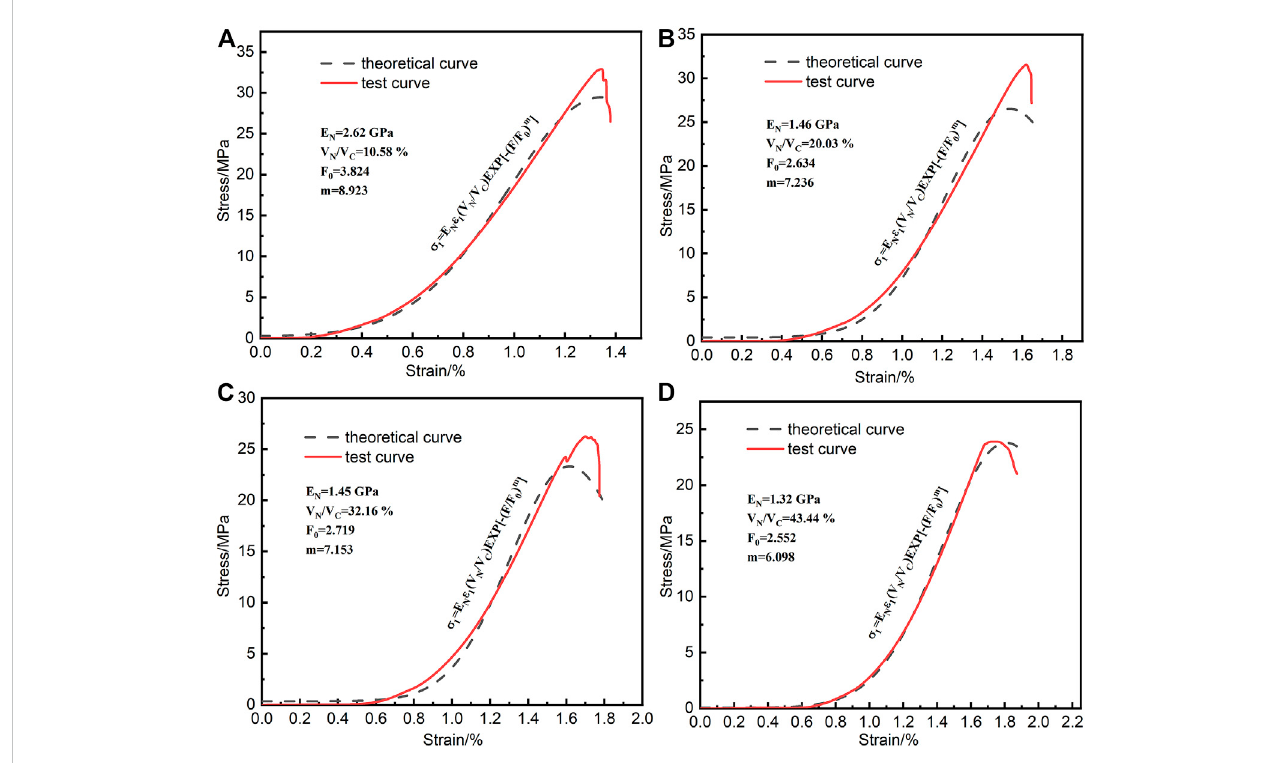
FIGURE 9 Comparison of freeze-thaw damage model and test data (A – D) represent 10, 20, 30, 40 freeze-thaw times, respectively.